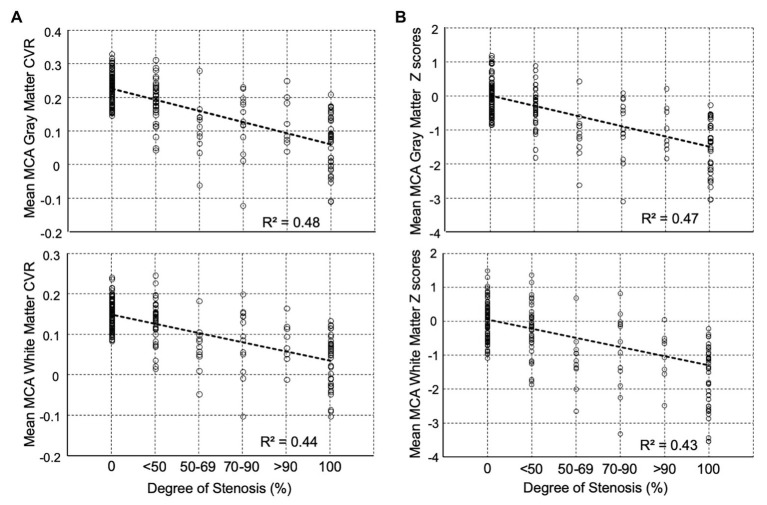
Distribution of mean middle cerebral artery (MCA) percent stenosis category for (A) CVR (Δ% BOLD/Δ mmHg PetCO2) and (B) z scores for both gray and white matters. Beyond 50% stenosis, the distribution of CVR no longer has the distribution of the control cohort. All pairwise multiple comparison rank test (Dunn’s Method) showed for gray matter that all groups differed from the control group (p < 0.05) except <50% stenosis group, and for white matter all groups were significantly different from the control group (p < 0.05) except for the <50% stenosis and 70–90% stenosis groups. Note: Abscissas in B show average z scores for all voxels in the MCA region of interest (ROI). In an individual subject, CVR values in a voxel may contain errors due to partial voluming, location misregistration, subject movement, position, and others; however, when all the voxels are averaged over a large ROI, they more truly represent the underlying physiology of the ROI. The ROI z score of individual healthy subjects was calculated by performing a “jackknife” procedure, which involved taking each healthy subject from the reference atlas, calculating a mean CVR and comparing it back to the corresponding atlas average CVR. The range of z scores in the healthy individuals (comparable to the standard error of the mean) in the atlas was ±1. CVR, cerebrovascular reactivity; BOLD, blood-oxygen-level-dependent; PetCO2, end-tidal partial pressure of carbon dioxide.